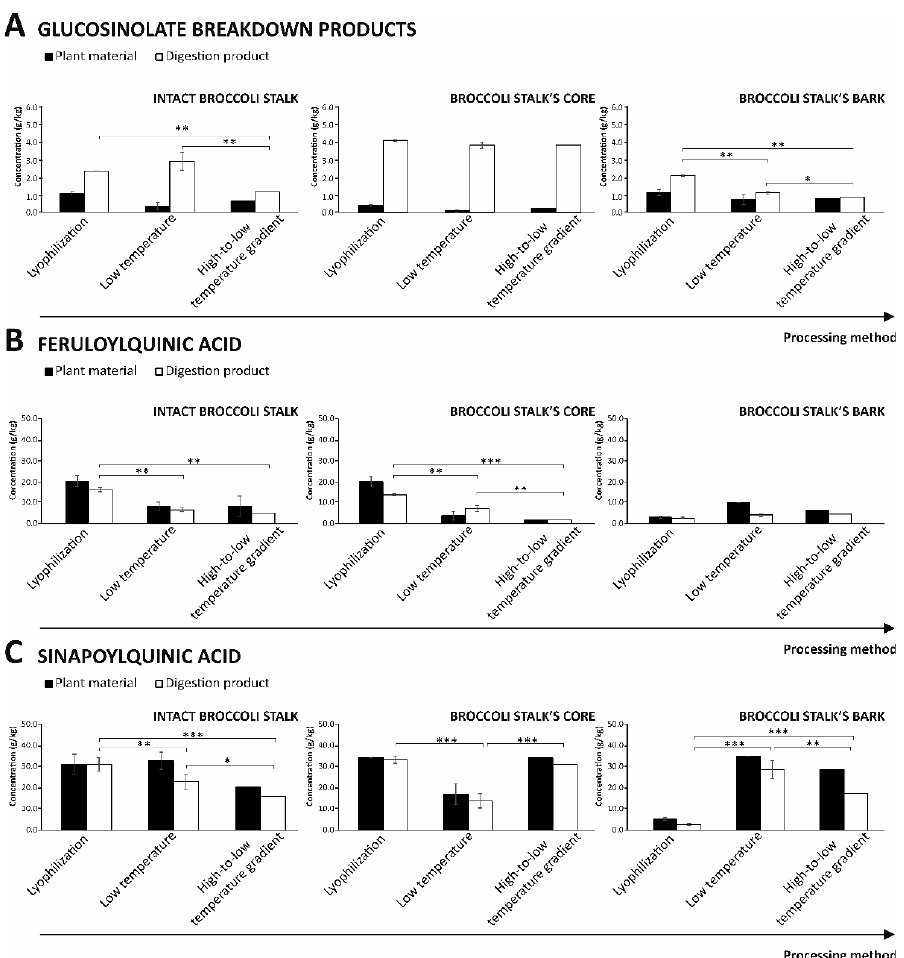
Figure 2. Content of glucosinolates breakdown products ( A ), feruloylquinic acids ( B ), and sinapoylquinic acids ( C) of in vitro gastrointestinal digestion products of lyophilized, low-temperature dried, and high-to-low temperature gradient dried broccoli stalks and co-products. Significant differences were according to a paired t -test ( p < 0.05 (*), p < 0.01 (**), and p < 0.001 (***)). The analysis of the concentration of feruloylquinic and sinapoylquinic acids in the digestion products evidenced that almost all treatments entailed a degradation of the phe- nolic fraction that remained in the rages of 1.8–13.6 mg/kg dw and 14.0–33.9 mg/kg dw for feruloylquinic (represented by 5-caffeoylquinic acid and p-coumaroylquinic acid) and sinapoylquinic (represented by di-sinapoyl glucoside) acids, respectively (Figure 2). Ac- cording to these results, the final concentration achieved for cores processed applying low-temperature drying provides 4.3-fold higher and 2.3-fold lower amounts of feruoylquinic and sinapoylquinic acids, respectively. Because of the lower concentration of feruloylquinic acids in the digestive products, this is the limiting factor that would in- dicate the capacity of the low-temperature process of the broccoli stalk’s core to retrieve the utmost quantitative profile of bioactive phytochemicals. This content is of special in- terest given the radical scavenging activity featuring phenolics with special emphasis on the prevention of lipid peroxidation [30,42]. These scavenging functions constitute a val- uable contribution to the biological functions attributed to the organosulfur compounds (mainly anti-inflammatory and anti-tumoral) since the reduction in the reactive oxygen